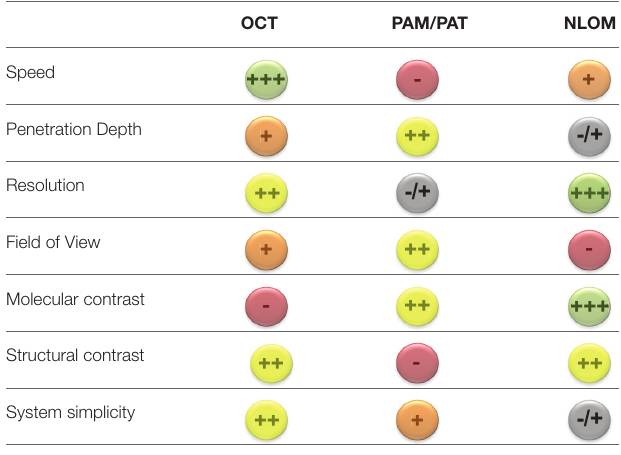
TABLE 3 | Multimodal OCT imaging with molecular contrast.